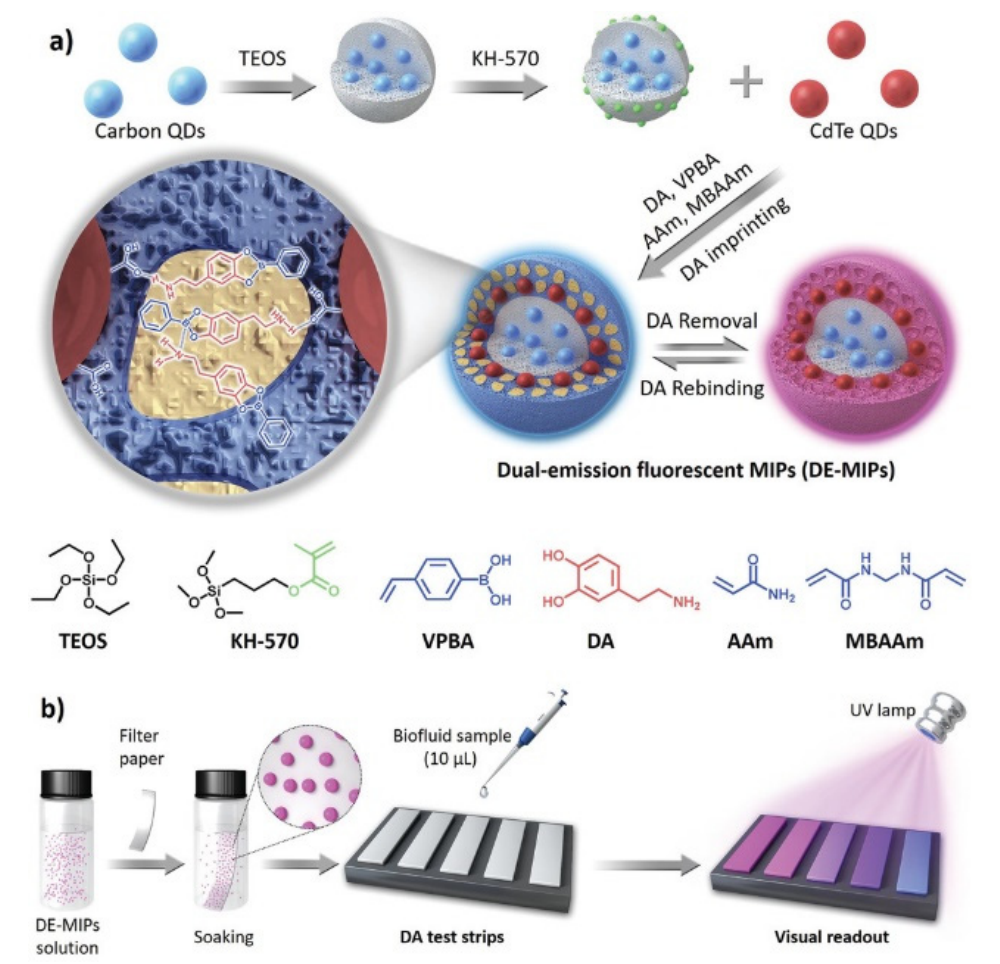
Figure 7. ( a ) Schematic generation of dual-emission fluorescent molecularly imprinted polymer nanoparticles (DE-MIPs) with specific DA affinity; ( b ) The DE-MIPs-coated filter paper as a facile DA test strip for visual detection. Reproduced with permission from [27]. Copyright 2019 John Wiley & Sons.